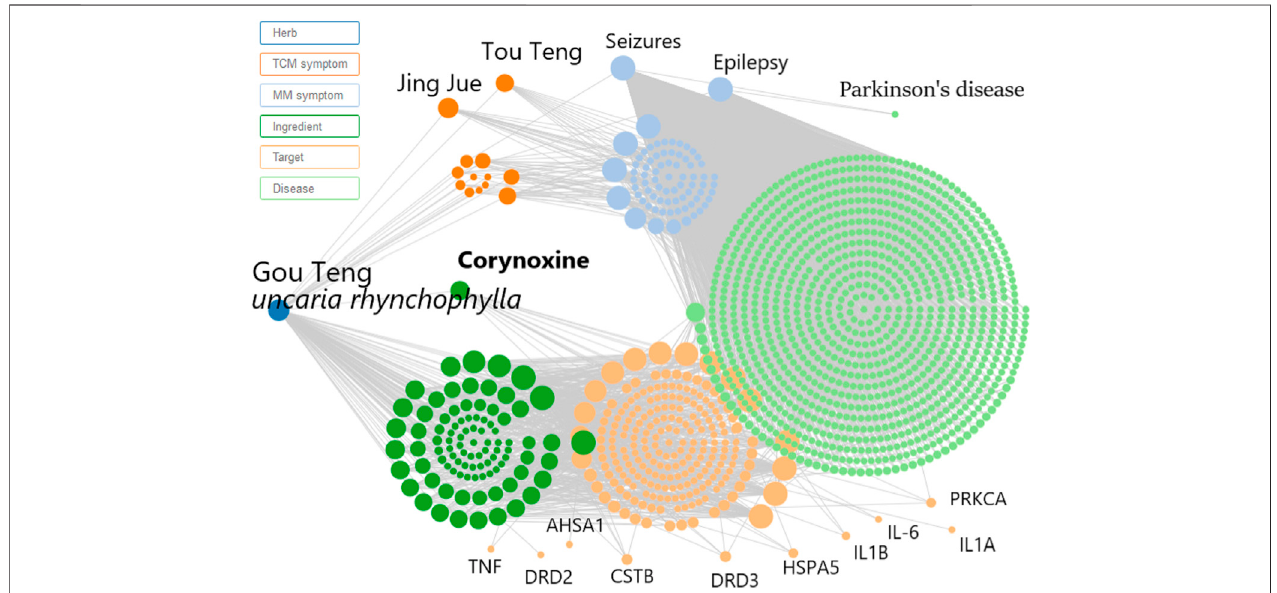
FIGURE3 | Network pharmacology predicts the mechanism ofCory in treating Parkinson ’ s disease. Inputting corynoxine into the SymMap (http://www.symmap. org/) database, we got 130 symptoms and 1700 targets. The presented symptoms and targets were screened by this network. And we selected the symptoms of Parkinson ’ s disease and targets involved in autophagy and neuroin fl